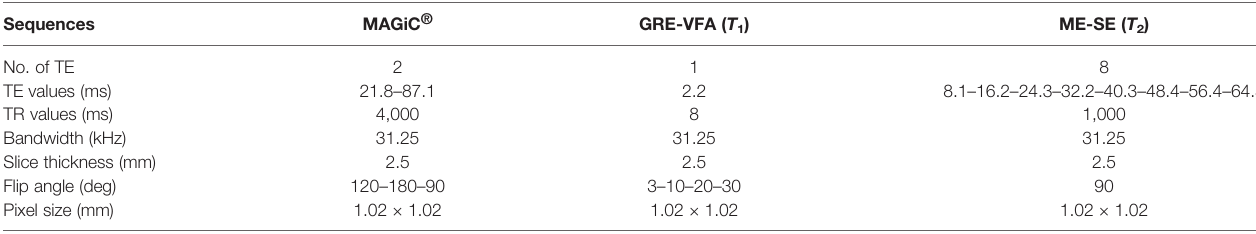
TABLE 1 | Acquisition parameters of the phantom images.